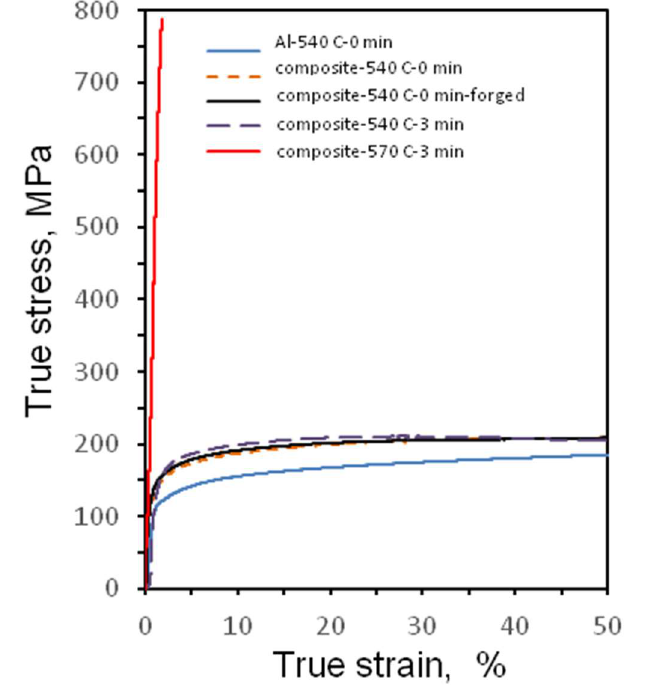
Figure 7. Compression true stress-true strain curves of composites obtained from Al-20 vol.%